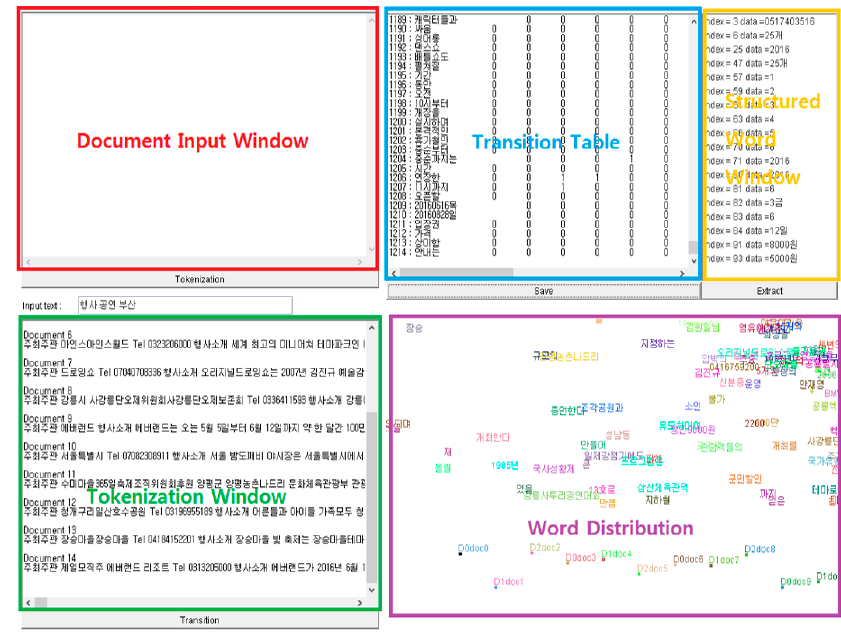
Figure 7. Example of a Latent Semantic Analysis (LSA) simulator.